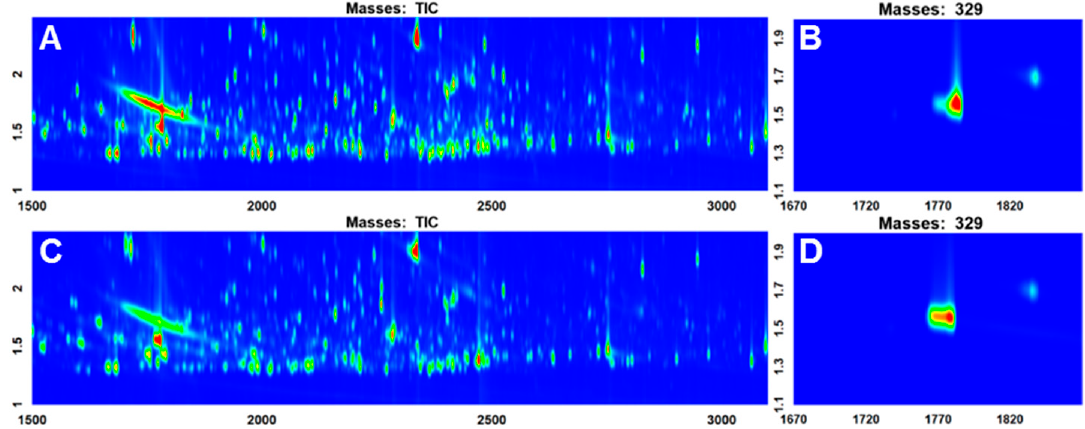
Figure 1. Comparison of two samples from the same subject. ( A ) S5M TIC (Total Ion Chromatogram),